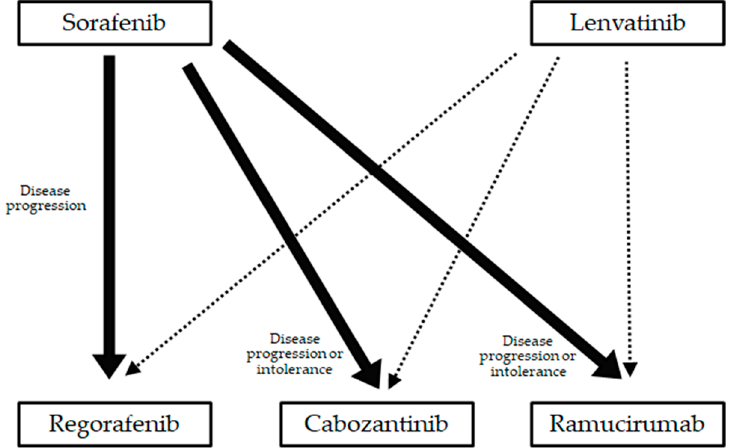
Figure 2. Post-progression treatment. The effective molecular targeted agents after the lenvatinib has not been established yet. not been established